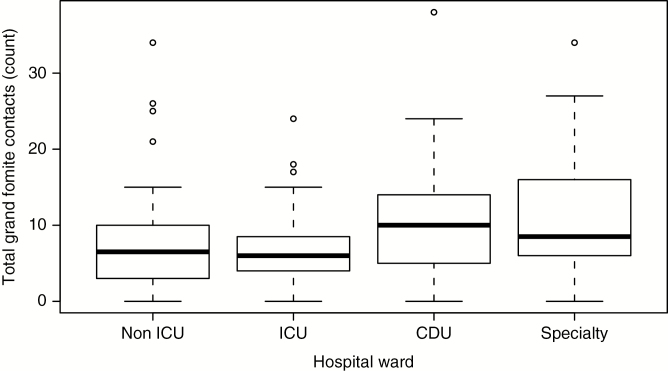
Fomite grand total contact, by hospital ward type. Abbreviations: CDU, clinical decision unit; ICU, intensive care unit.